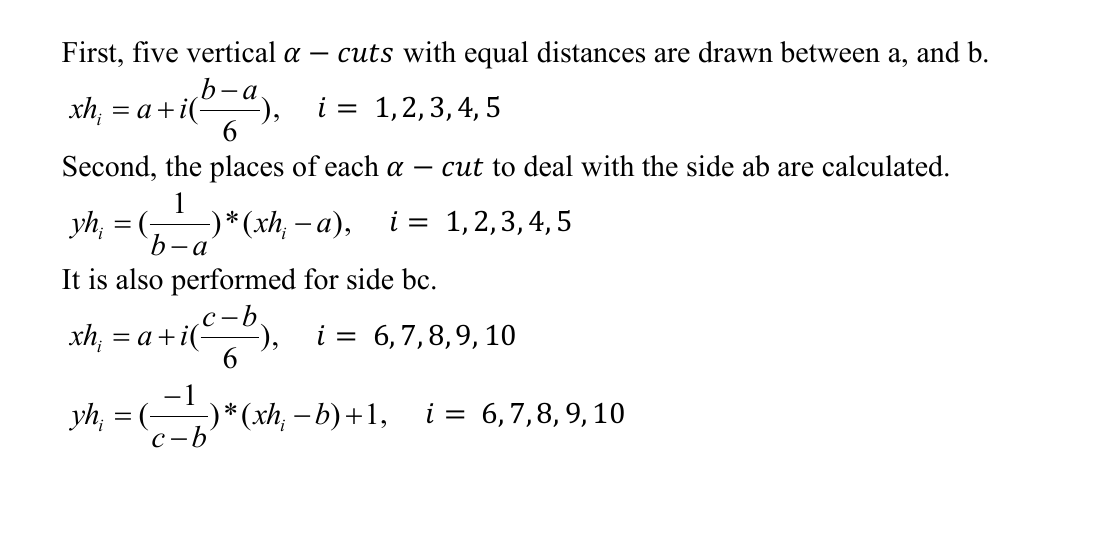
Fig. 3. Comparison between two triangular fuzzy numbers with no vertical sides (𝑎 ≠ 𝑏 ≠ 𝑐)